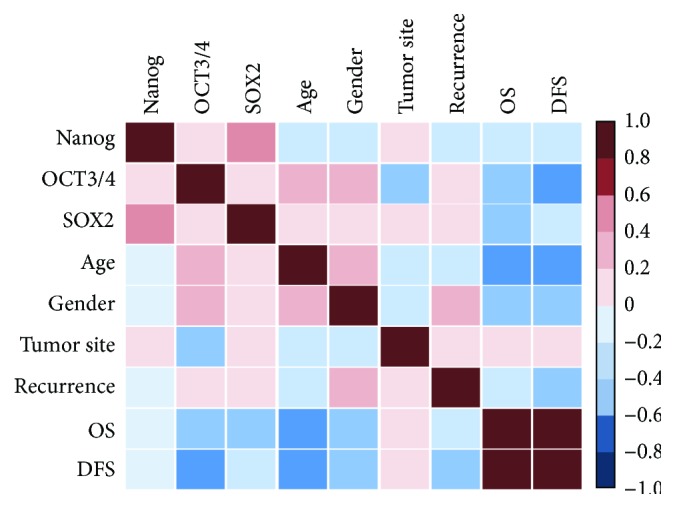
Correlation matrix between transcriptomic signature and the clinicopathological features. Pearson's correlation analysis was performed and represented as color gradient.